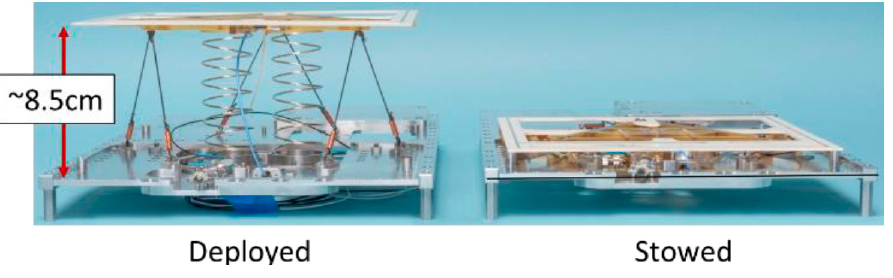
Figure 8. UHF loop antenna [8].